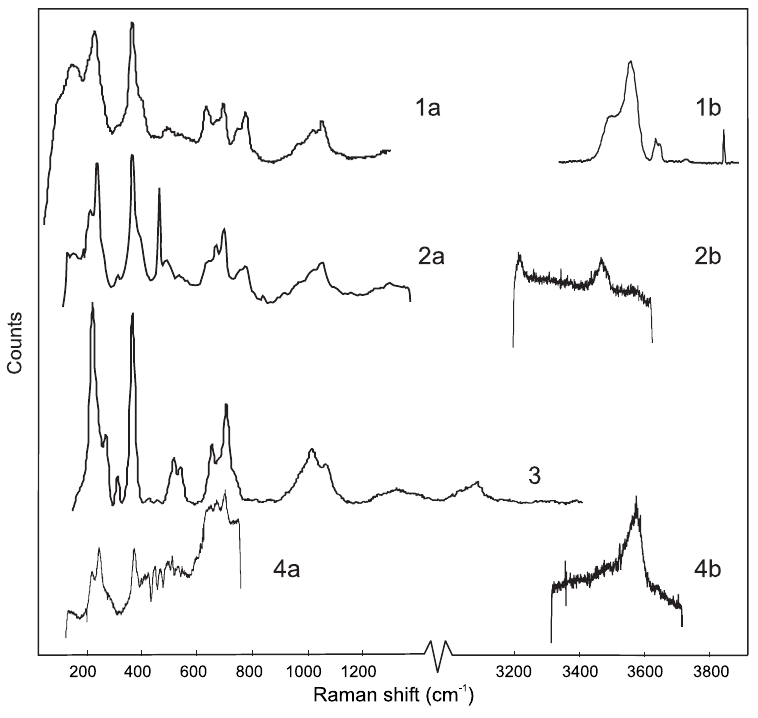
Fig. 7 – Raman spectra of (1) schorl GRR#794 from Cahuilla Mountain, River- side (California); (2) tourmalines from metachert LJ10 and tourmalinite T12 (Tapera Grande); (3) magnesiofoitite from Honshu (Japan), and (4) tourmaline from quartz vein FQ112-3a (Quartzito).